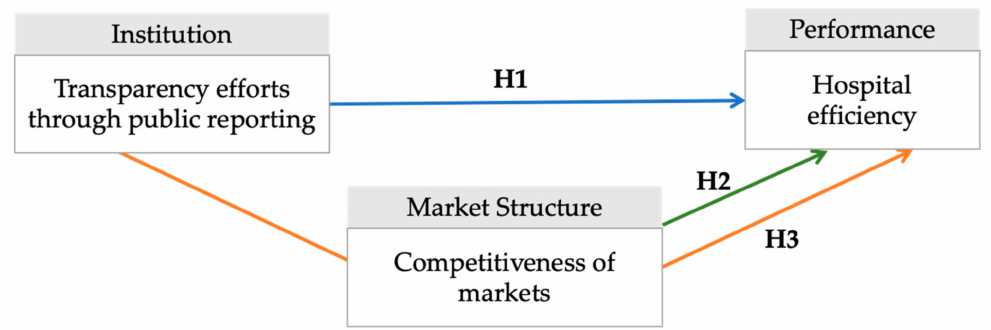
Figure 1. Model of the effects of public reporting and competition on